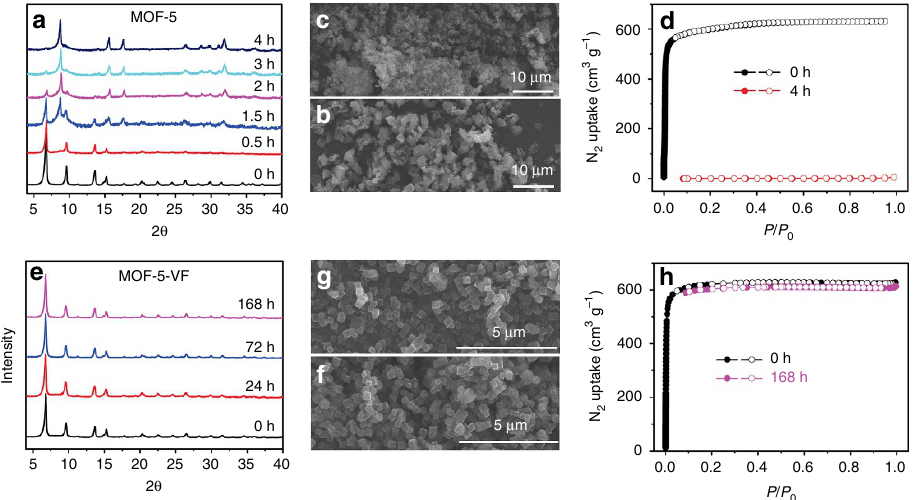
Figure 6 | Stability comparison of MOF-5 and MOF-5-VF. ( a , e ) Selected PXRD patterns of MOF-5 and MOF-5-VF ageing under 1atm of water saturated CO 2 at 45 (cid:2) C for different duration times. ( b , c ) SEM images and ( d ) N 2 sorption isotherms of MOF-5 before and after ageing under the above conditions for 4h. ( f , g ) SEM images and ( h ) N 2 sorption isotherms of MOF-5-VF before and after aging under the above conditions for